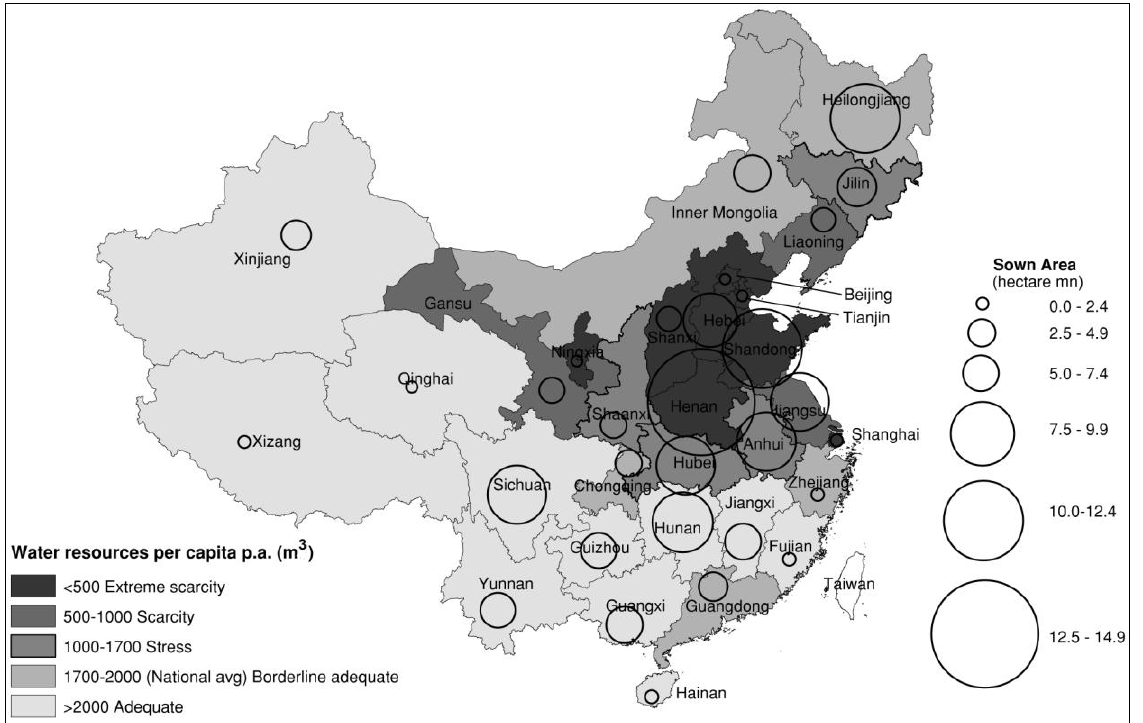
Fig. 5. China’s 2012 sown area mapped onto water resources (Source: Tan,